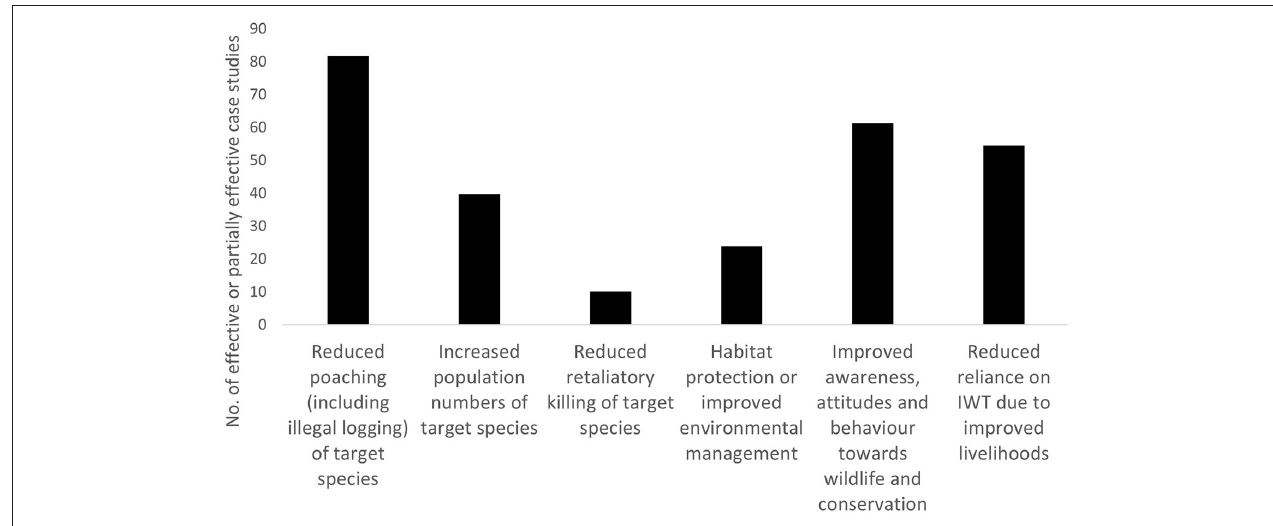
FIGURE 3 | Frequency with which different outcomes were cited as evidence that an intervention is effective or partially effective against